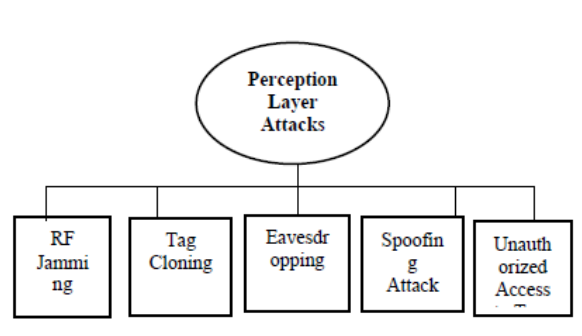
Figure 4. Perception Layer